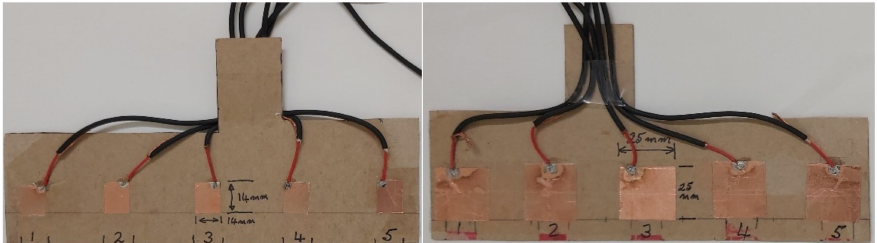
Figure 10. Capacitive touch sensor setup in blocks of both 14 mm × 14 mm and 25 mm × 25 mm detector